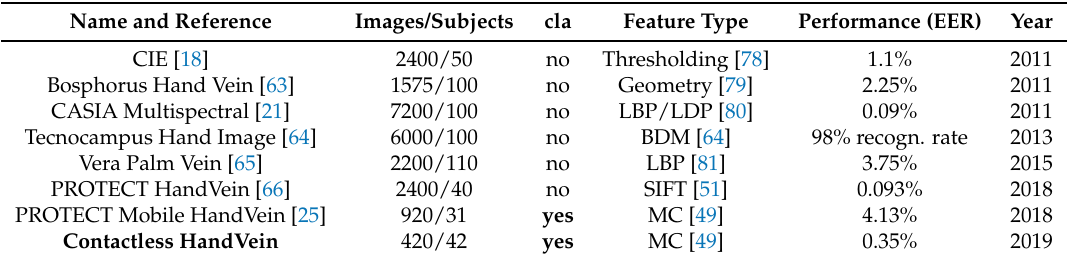
Table 5. Related performance results of publicly available hand vein recognition datasets, ordered by publication year. The “cla” column indicates contactless